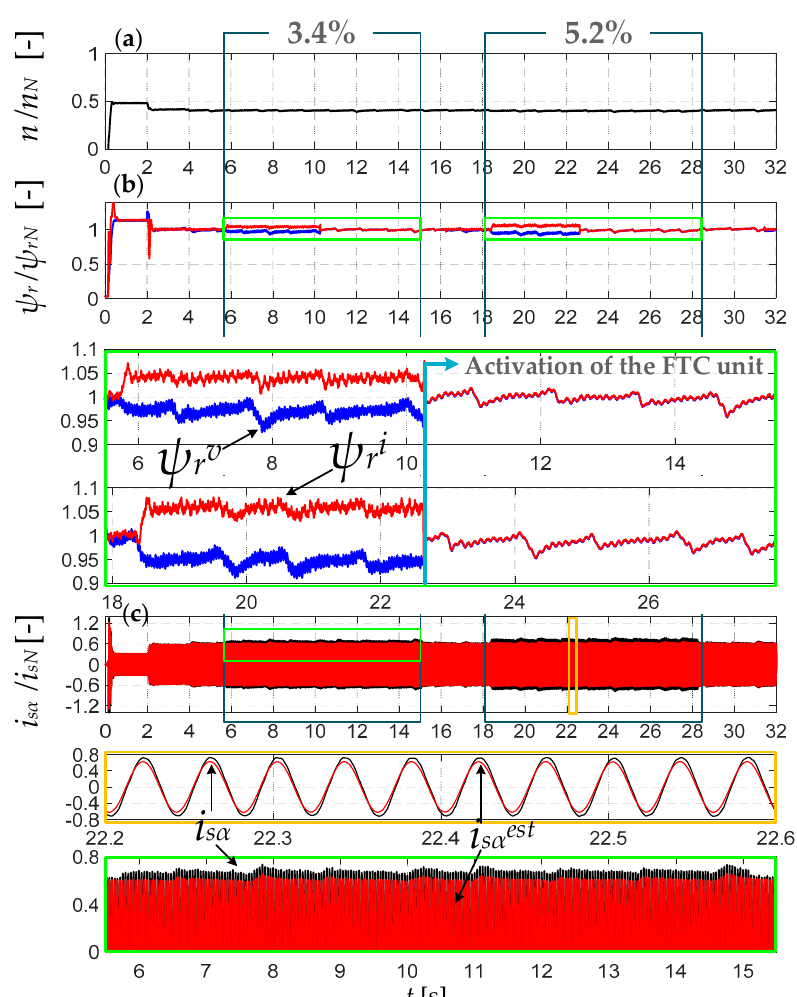
Figure 15. Operation of open-loop control scheme (v / f ) during ITSC with FTC unit: ( a ) measured rotor speed, ( b ) estimated rotor flux, ( c ) estimated and measured stator current in phase A; (experimental results), ( n ref = 0.5 n N , T l = 0.5 T N ).